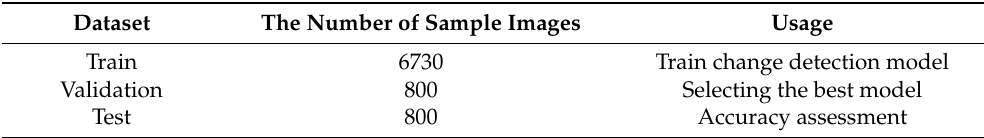
Table 5. Deforestation detection dataset